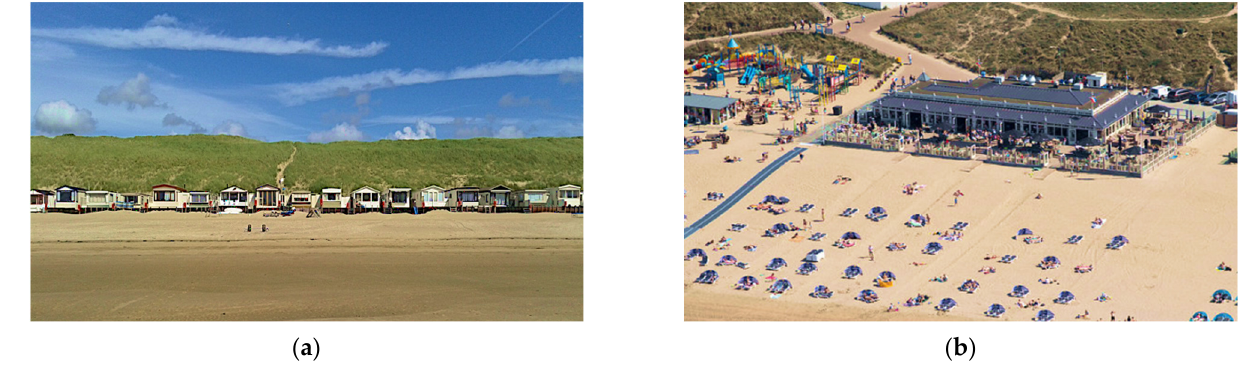
Figure 1. Buildings at beach–dune interface on the ( a ) Egmond beach, and ( b ) Zandvoort beach